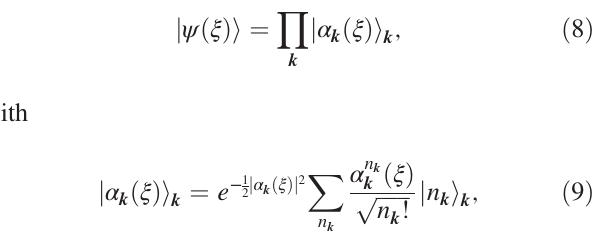
FIG. 2. The beam splitter model for quantum efficiency of a nonideal